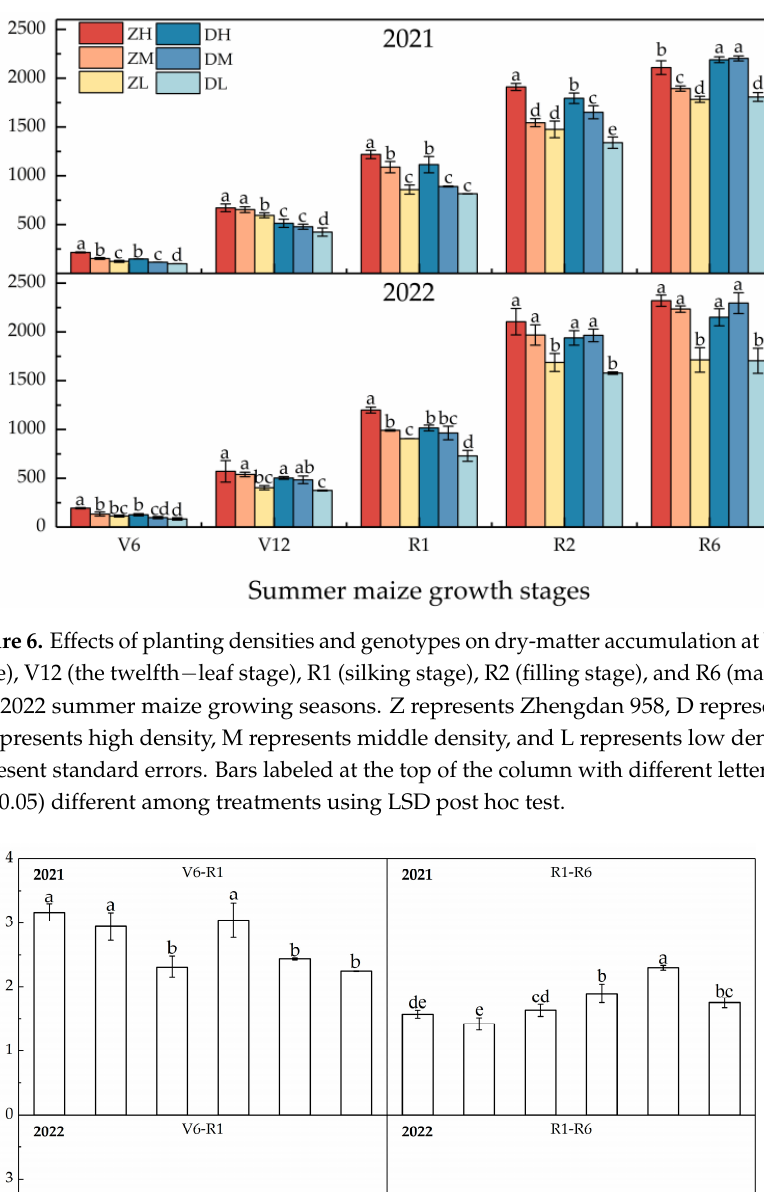
Figure 7. Effects of planting densities and genotypes between V6 (the sixth − leaf stage), R1 (silking stage), R1 (silking stage), R6 (mature stage) on radiation − use efficiency in 2021 and 2022 summer maize growing seasons. V6 − R1 represents the stage from V6 to R1, R1 − R6 represents the stage from R1 to R6; Z represents Zhengdan 958, D represents Denghai 605; H represents high density, M represents middle density, and L represents low density. Vertical bars represent standard errors. Bars labeled at the top of the column with different letters are significantly ( p < 0.05) different among treatments using LSD post hoc test.